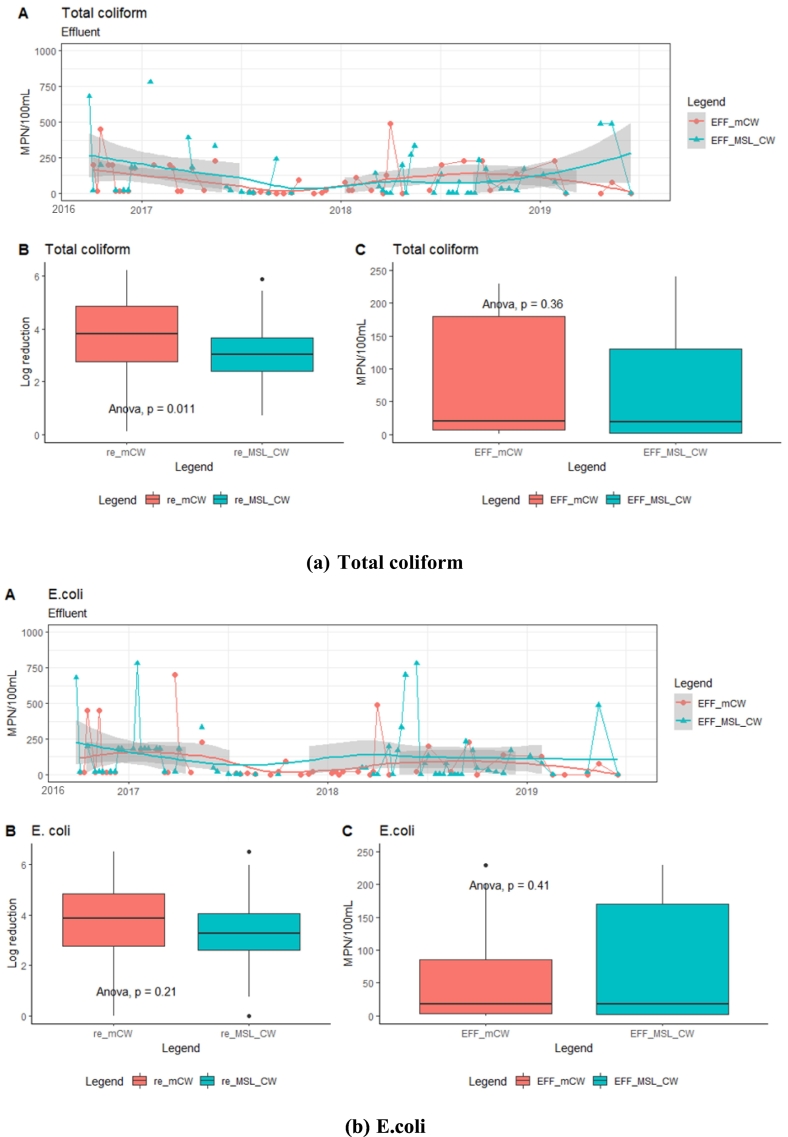
Time-series analysis of effluent concentrations and box plots (log reduction and effluent concentration (EFF)): Total coliform and E.coli.